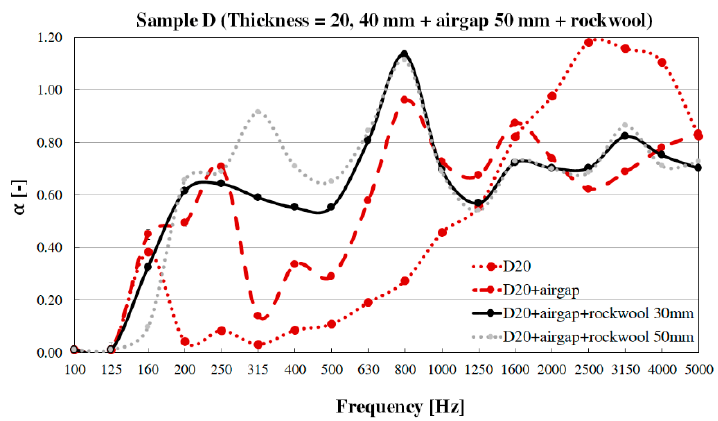
Figure 8. Sample D single layer of 20 mm combined with an air gap of 50 mm filled with a rock wool layer of 30 and 50 mm.